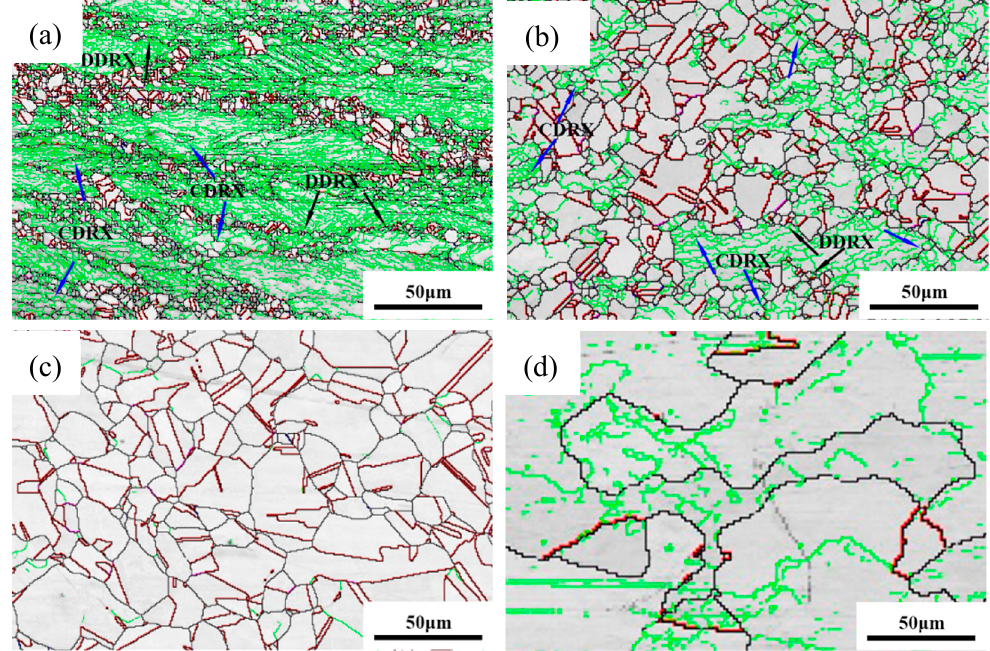
Figure 9. EBSD grain boundary maps of compressed samples ( a ) 1000 ◦ C, 1 s − 1 ( b ) 1100 ◦ C, 0.1 s − 1 ( c ) 1200 ◦ C, 1 s − 1 ( d ) 1200 ◦ C, 0.01 s − 1 (2–15 ◦ green, Σ 3 red, Σ 9 purple, Σ 11 yellow, Σ 27 aqua and other boundaries black).